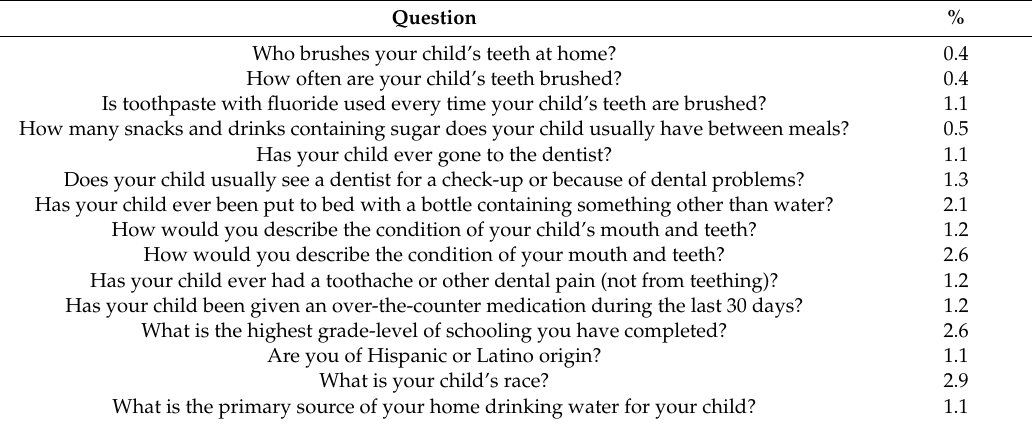
Table 2. Percentage of missing responses in individual questionnaire